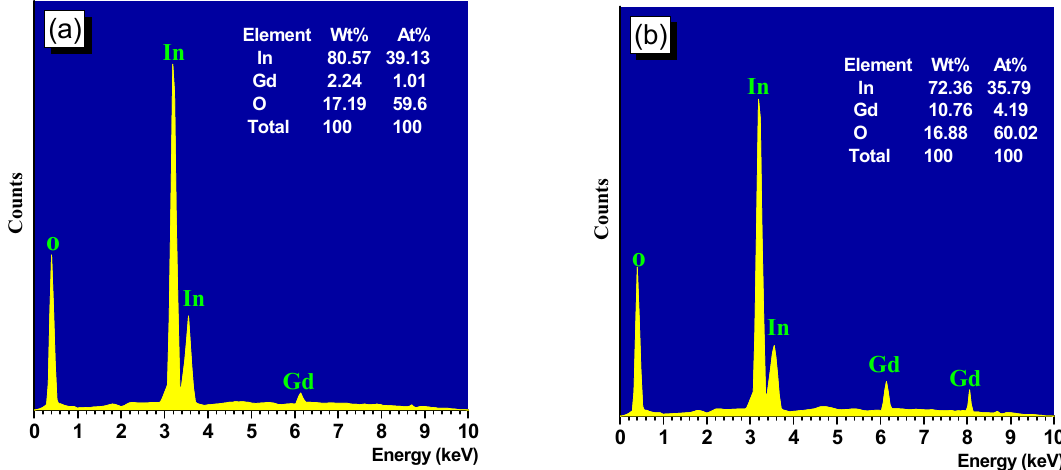
Figure 4. EDAX of ( a ) (In 0.98 Gd 0.02 ) 2 O 3 and ( b ) (In 0.90 Gd 0.10 ) 2 O 3 thin films. SEM pictures of the In 2 O 3 and (In 0.90 Gd 0.10 ) 2 O 3 thin films created on glass substrates are shown in Figure 5a,b. The pictures show both films’ high adhesion and thick, erratic structure. In terms of the histograms (in Figure 6c,d of Figure 5a,b, the average grain size distribution was calculated using Gauss curve fitting and was discovered to be 40 nm and 25 nm for x = 0.0 and 0.1, respectively, as shown in the histogram of Figure 5a,b. These numbers are higher than the XRD-measured crystallite size. The XRD measurement grain size was established between the grain boundaries. AFM enables the acquisition of a